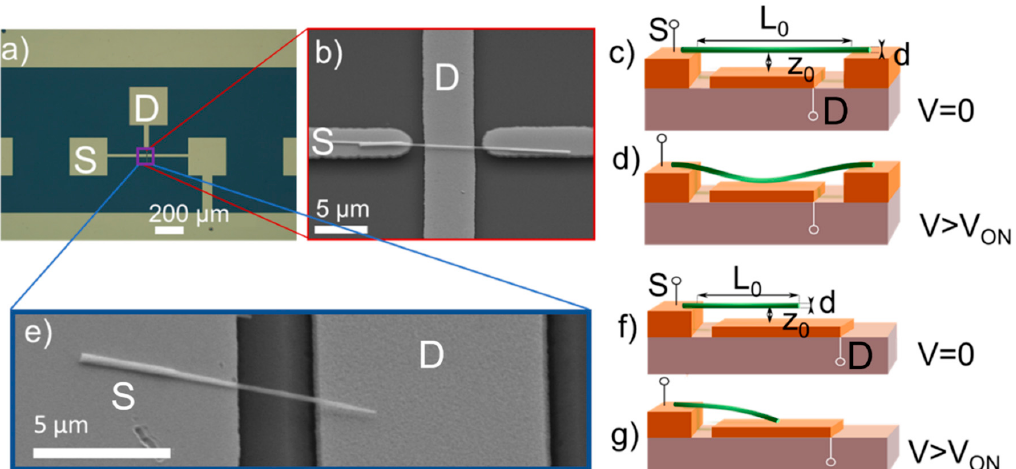
Figure 2. ( a ) Optical microscope image of a device connected to a micropatterned gold electrode line that joins it with other devices; ( b ) SEM image of a double-clamped single nanoelectromechanical (NEM) switch device in an array of 2 µ m wide electrodes; ( c ) Schematics for a double-clamped nanowire switch in OFF and ( d ) ON state; ( e ) SEM image of a single-clamped nanowire in an electrically identical setup with wide (20 µ m) DEP electrodes; ( f ) Schematics for a single-clamped nanowire switch in OFF and ( g ) ON state. Relevant design parameters shown in ( c , d , f , g ) are suspended nanowire length L 0 , nanowire diameter d and distance between nanowire and electrode z 0 .